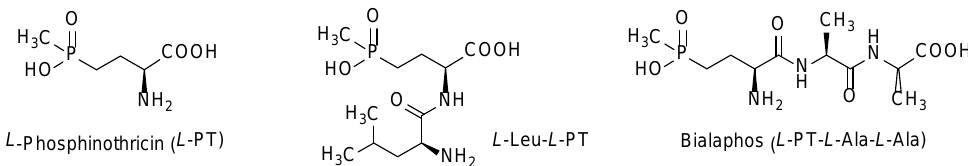
Figure 1. Chemical structures of L -phosphinothricin ( L -PT), L -leucyl- L -phosphinothricin ( L -Leu- L -PT) and L -phosphinothricyl- L -alanyl- L -alanine (Bialaphos, L -PT- L -Ala- L -Ala).